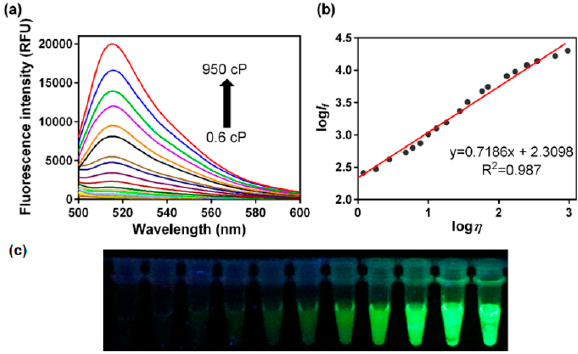
Figure 2. Viscosity-dependent fluorescence spectra of BTV in solvent mixtures. ( a ) Changes of fluorescence spectra of BTV (10 µM, λ ex = 470 nm, 25 °C) with the variation of solution viscosity (methanol-glycerol system); ( b ) The linear response between log I 515 and log η ; ( c ) Color and fluorescence changes of BTV (10 µM) in mixed solvents (methanol-glycerol) with various viscosities under a UV lamp (365 nm excitation).